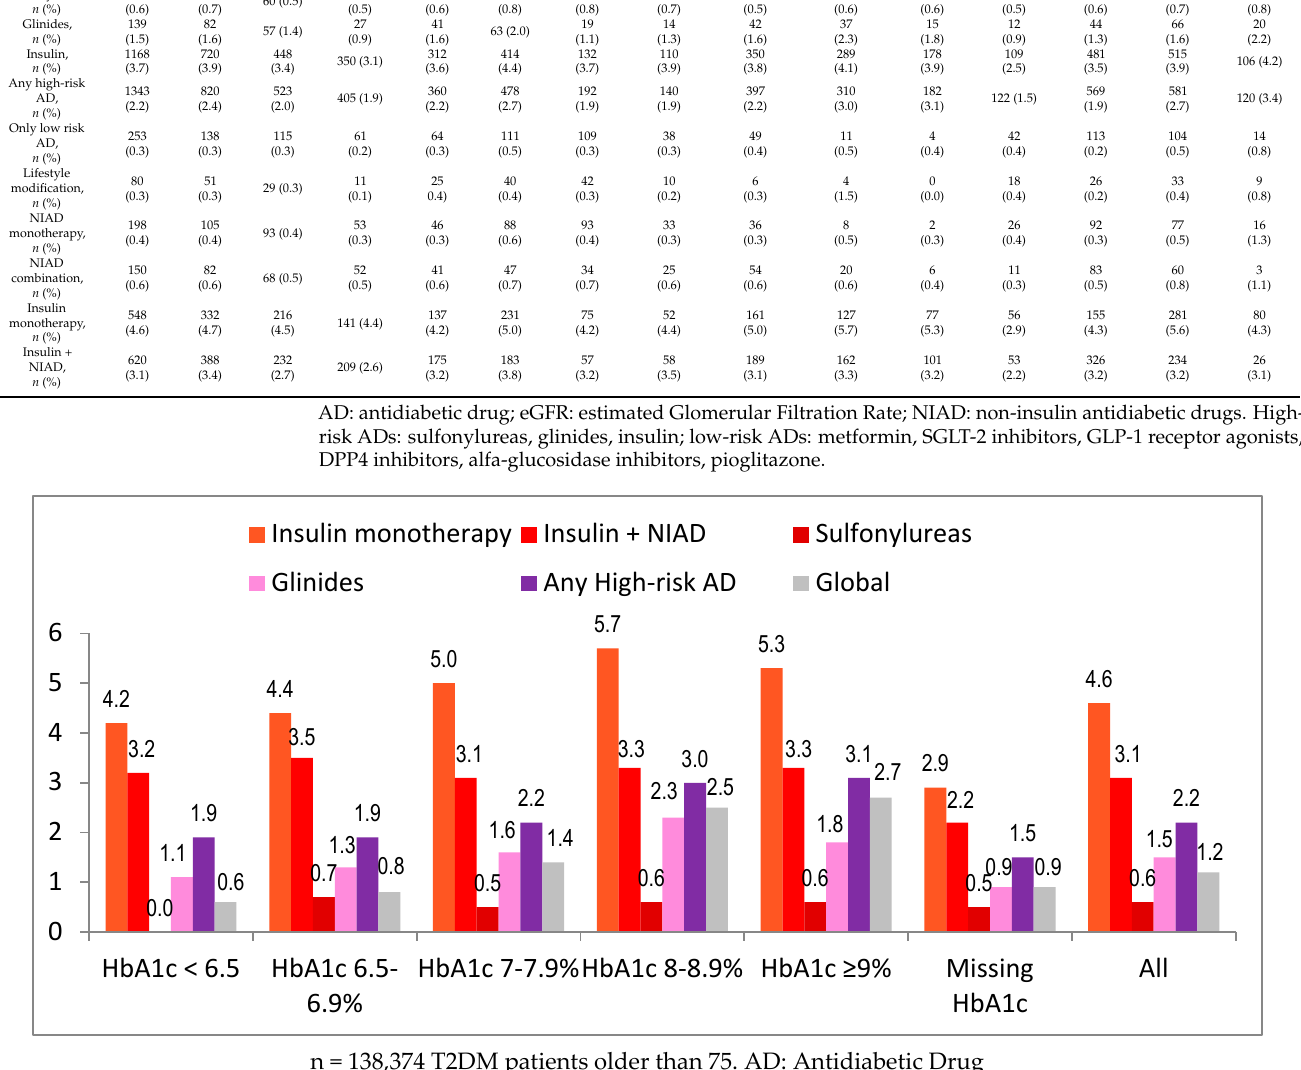
Figure 4. Registered hypoglycemia according to the use of high-risked antidiabetic drugs and HbA1c categories. n = 138,374, T2DM patients older than 75. AD: antidiabetic drug.